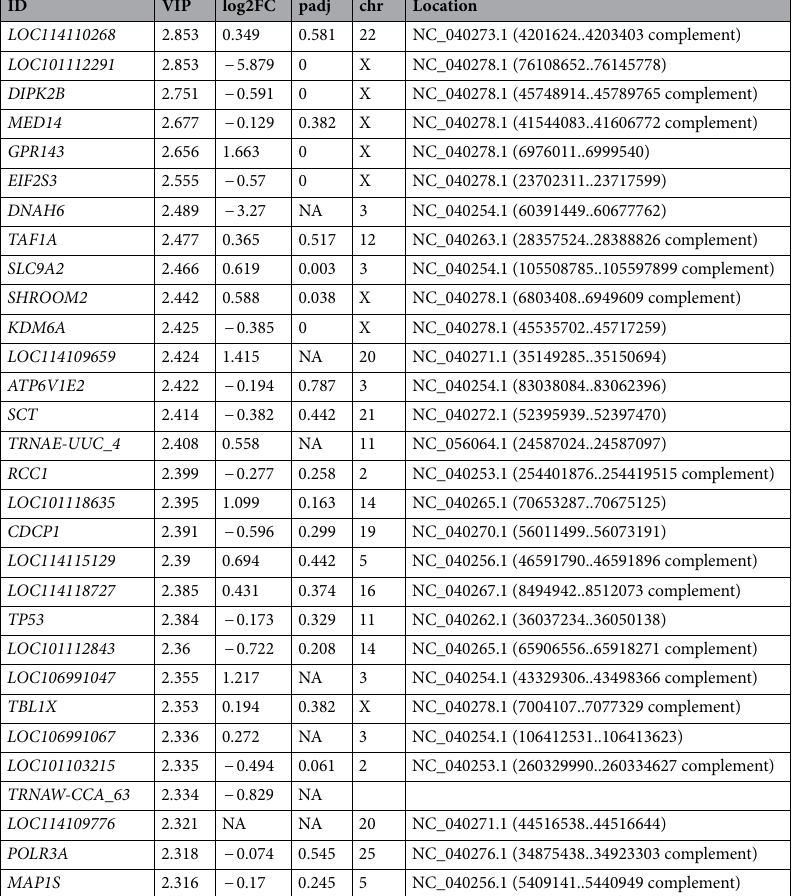
(Figure S4). Analysis by DESeq2 after removal of the outliers from lncRNA, snoRNA and snRNA and keeping all samples for miRNA (no outliers were observed in miRNA), found no significant effect of gestational T treatment on any ncRNA in differential expression analysis (lncRNA, miRNA, snoRNA, snRNA) (Supplemental Figure S6, Table S8). The potential ncRNA signatures of gestational T excess of female LV based on PLS-DA model VIP values are listed in Supplemental Table S9; none of these met the criteria of FDR < 0.05. Male. Across all classes of ncRNA studied in the male fetal LV, 2D and 3D PCA plots generated by unsupervised clustering showed an overlap between control and gestational T-treated groups. PLS-DA based supervised model demonstrated a clear separation of T treated vs control fetal LV tissue ncRNA expression profiles (lncRNA and snoRNA—Fig. 7, PCA and PLS DA models of all ncRNA classes are included in Supplemental Figure S5). Gestational T treatment modulated 15 different lncRNAs and 27 different snoRNAs at FDR < 0.05 and absolute log2FC > 0.5. The potential non-coding RNA signatures of T treatment on male fetal LV based on PLS-DA model VIP values are listed in Supplemental Table S10. One of the snoRNA LOC114114258 which was identified as a potential snoRNA signature for T treatment on male fetal LV was also significantly differentially expressed in DESeq2 analysis.